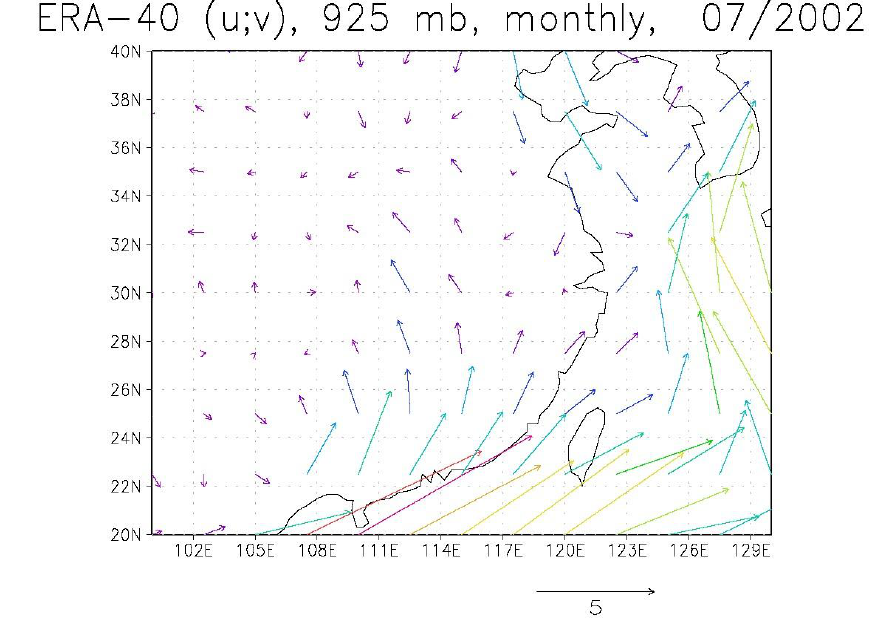
Figure 3. ECMWF analysis monthly wind at 925 mb for July